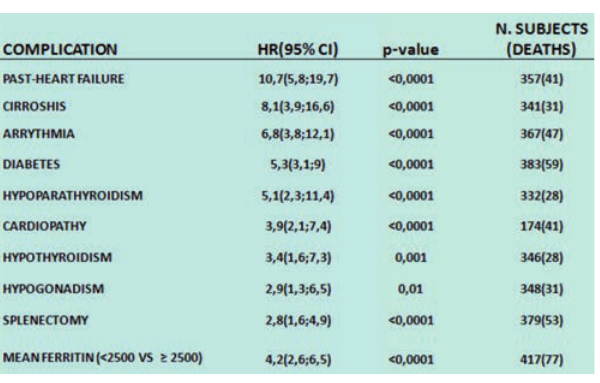
Figure 3. Summary of overall survival based on separate cox regression models for single complication (Maggio et al. , 2012,unpublished